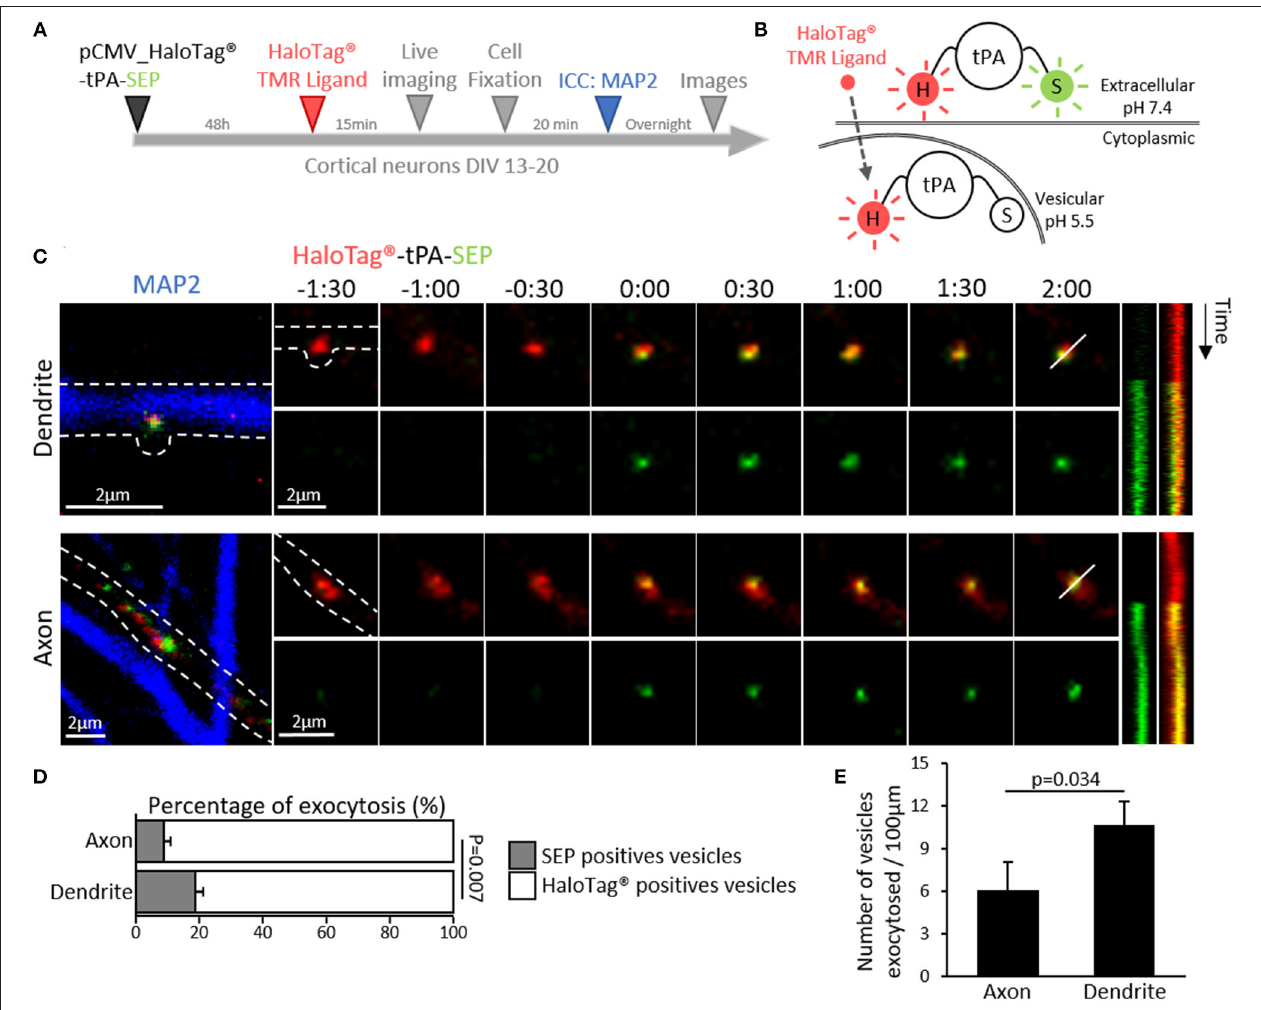
FIGURE 6 | Dendritic and axonal release of tPA. (A) Timeline of the experiment. (B) Schematic diagrams of a dual color reporter for neuronal tPA. tPA fused to a HaloTag ® site and the superecliptic pHluorin (SEP) allows simultaneous visualization of total (HaloTag ® ) and extraneuronal (SEP) tPA molecules. (C) Representative z-stack confocal images of transfected cortical neurons (DIV12) with pCMV_HaloTag ® -tPA-SEP plasmid (TMR ligand; in red and SEP; in green), time-lapse were acquired in 2 dimensions every 30s ( t = 0 was assigned of exocytosis; Time is in min:sec). After live imaging ICCs were performed to reveal MAP2 (in blue) and thus to differentiate axons from dendrites (an example of each are shown). Respective kymographs of HaloTag ® -tPA-SEP exocytosis are shown. Scale bar represents 2 µ m. (D) Histograms show the percentages of exocytotic tPA-containing vesicles (SEP positives puncta, in green) compared to the total pool of tPA-containing vesicles (TMR positives puncta, in red) in axons (9%) and in dendrites (19%) ( N = 16 and N = 14 neurons respectively, from N = 7 independent cultures, p = 0.007). (E) Schematic histograms of the number of vesicles exocytosed per 100 µ m in axons (6) and dendrites (11) ( N = 13 and N = 11 neurons respectively, from N = 5 independent cultures, p =